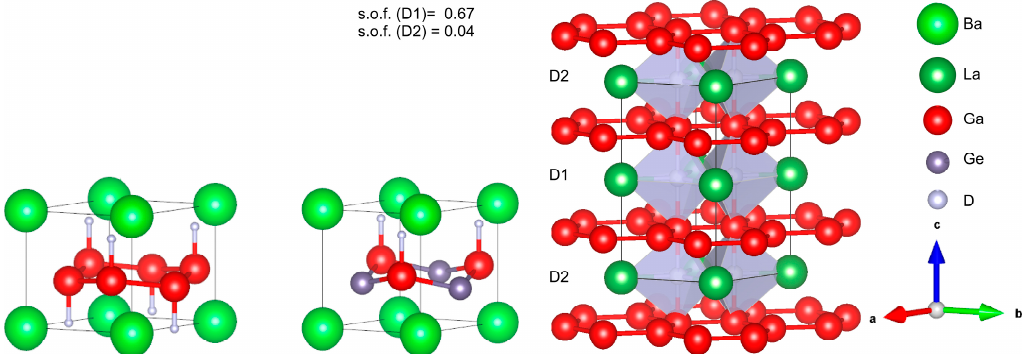
Figure 3. Crystal structures of BaGa 2 D 2 ( left ), BaGaGeD ( middle ) and LaGa 2 D 0.71(2) ( right ). Covalent bonds of the polyanions are emphasized.